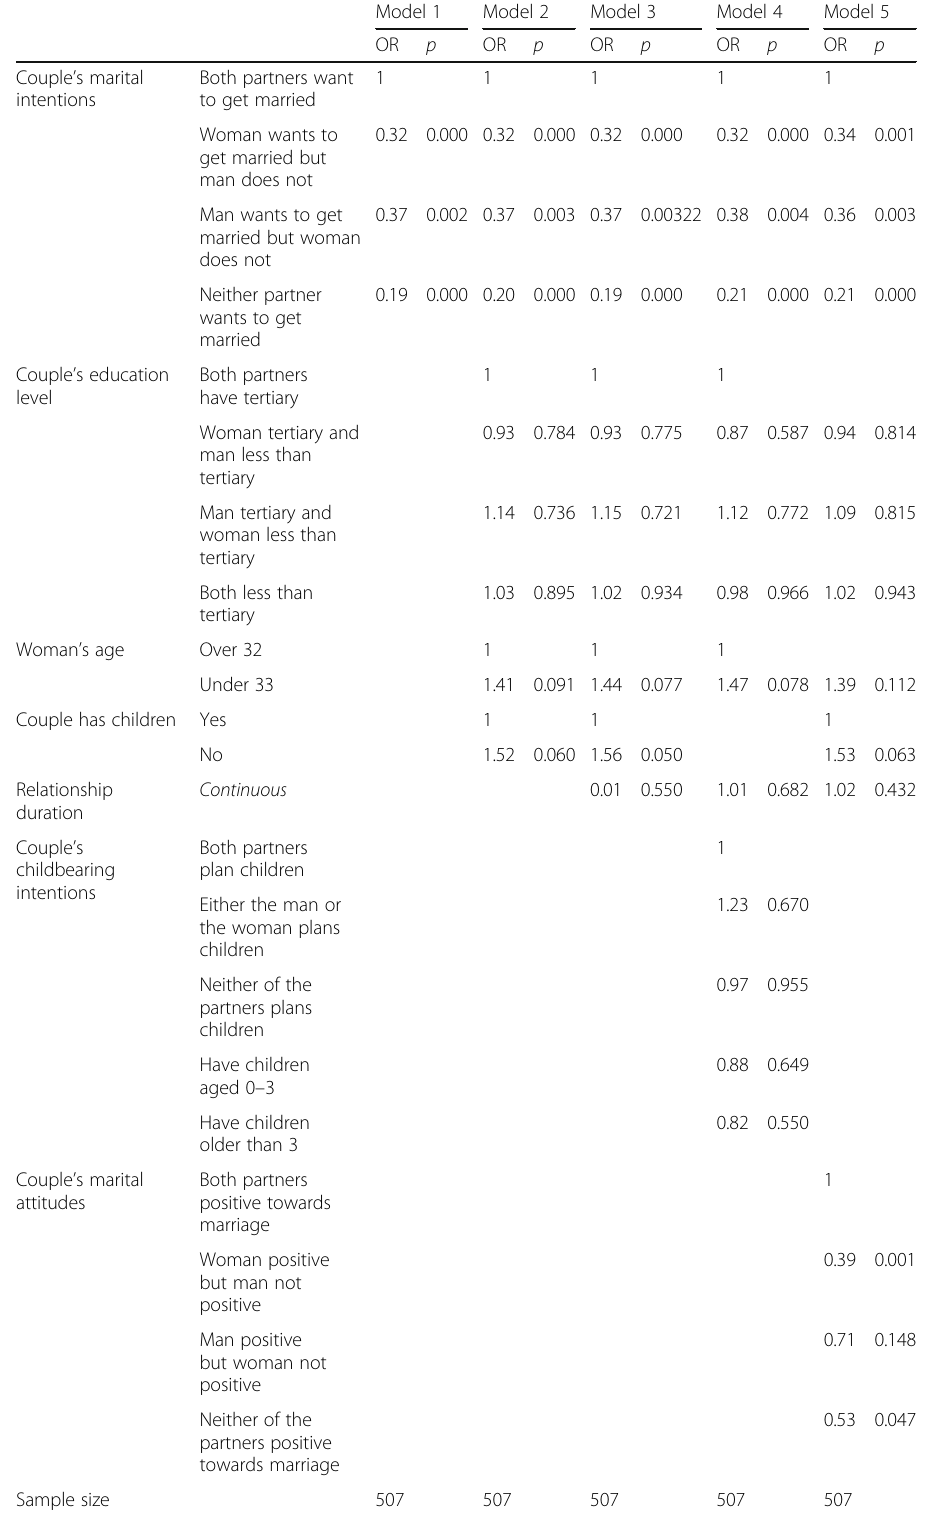
Table 4 Odds of marriage by marital intentions among cohabiting couples, stepwise logistic